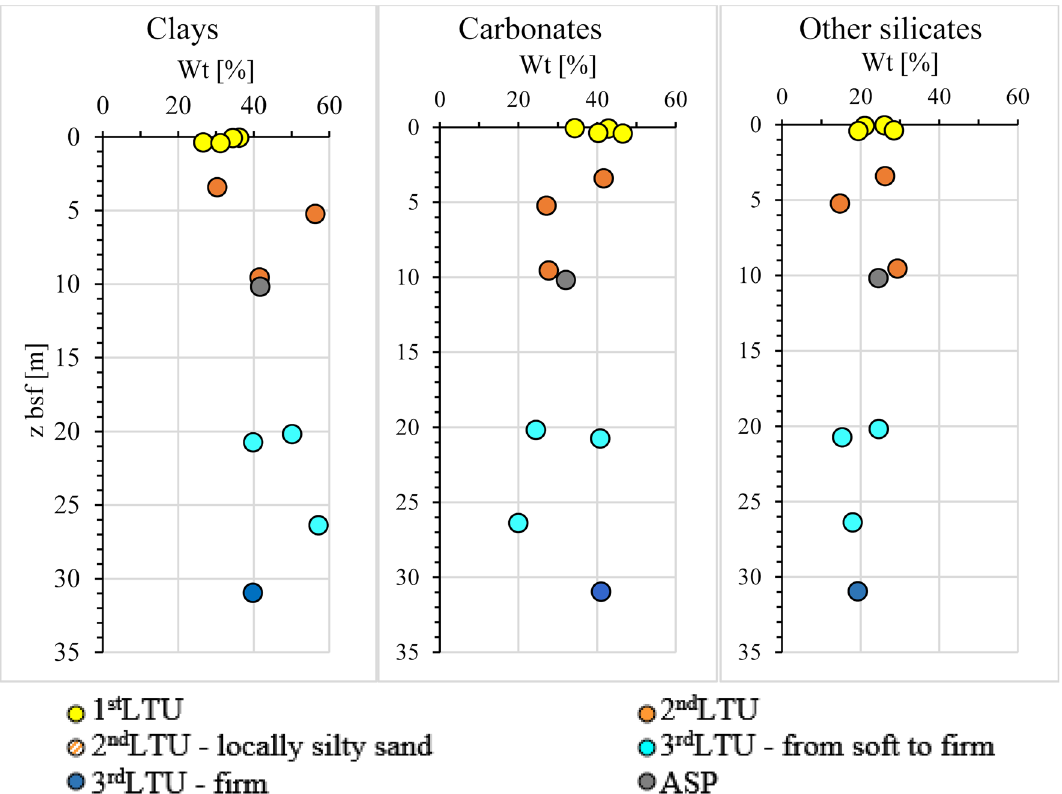
Figure 9. Profiles of mineralogical composition of the samples collected within different LTUs (sites S1, S2, S3, S4, S6, S7 of section N–N ′ in Fig. 2).